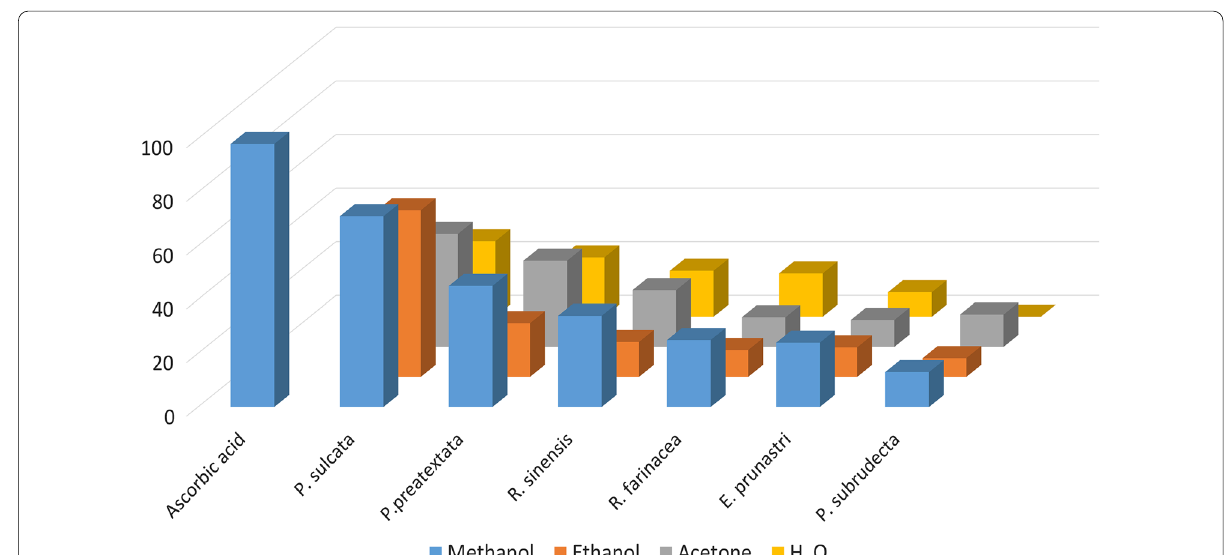
Fig. 1 DPPH radical scavenging activity (%) of methanol, ethanol, acetone extracts and aqueous infusion of P. sulcata R. sinensis P. praetextata R. farinacea, P. subrudecta and E. prunastri . Ascorbic acid was used as positive